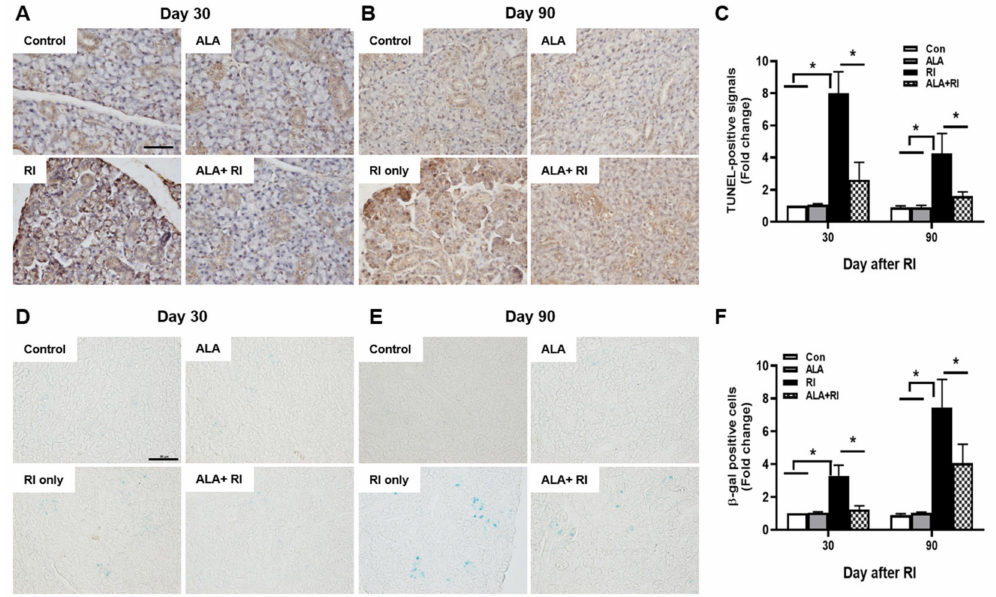
Figure 3. Increased cellular apoptosis and senescence after RI therapy. Tissues were dissected from each mouse, fixed in 4% paraformaldehyde, and cut into sections 5 µ m thick. ( A – C ) Apoptosis was examined by terminal deoxynucleotidyl transferase biotin-dUTP nick end labeling (TUNEL) assay. Positive signals were detected in the nuclei of the acinar and ductal cells in the RI only group and signal intensity was greater at 30 days than 90 days post-RI therapy. Serial sections were assessed for β -galactosidase activity by staining with X-gal (blue) ( D – F ). Note the appearance of β -galactosidase staining in the acinar and ductal cells from the RI only group. ( A , D ) 30 days post-RI therapy; ( B , E ) 90 days post-RI therapy. Data are means ± SD. * P < 0.05 compared to the indicated groups. Scale bars: 100 µ